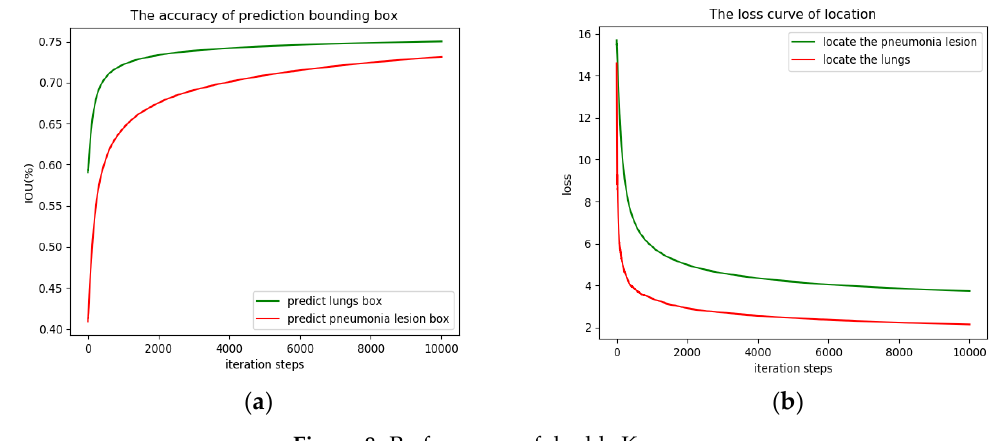
Figure 8. Performance of double K-means.